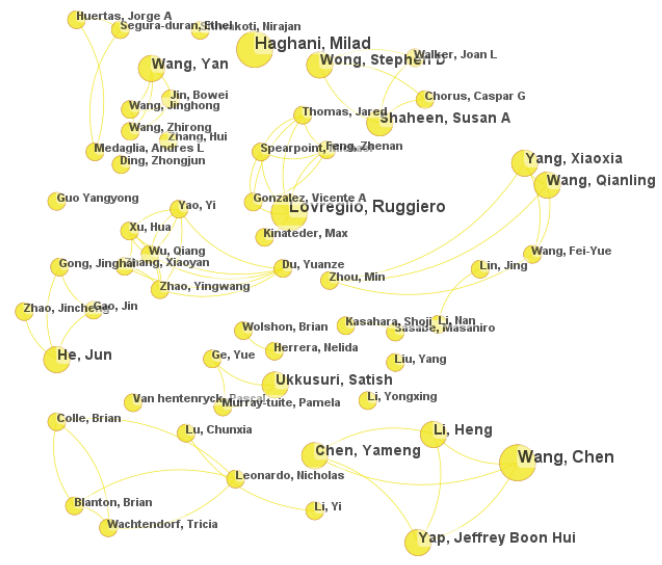
Figure 5. Science mapping of authors.